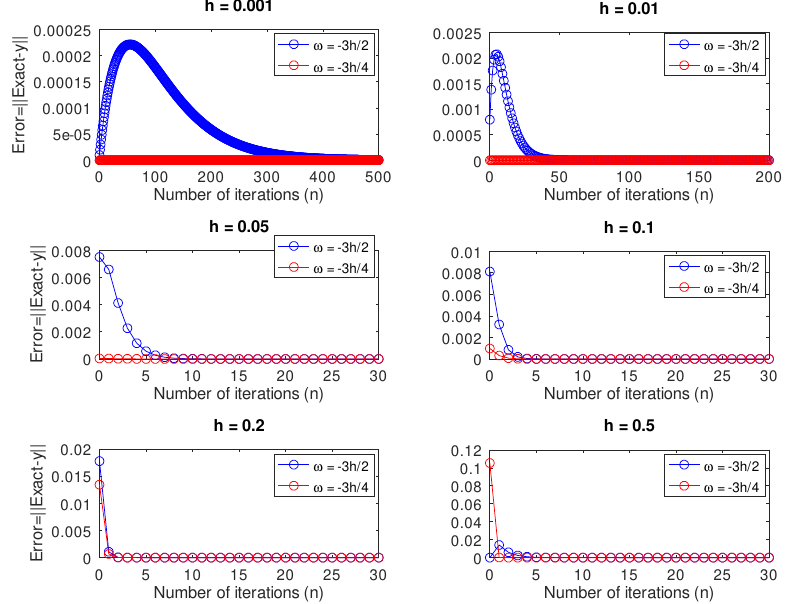
Figure 12. Comparison of the norm of the difference between the exact solution and the vector [ y n + 1 , y ] T for different values of h using the discrete schemes (3)–(6) corresponding to ω = n + 3 2 and the discrete schemes (7)–(10) corresponding to ω =